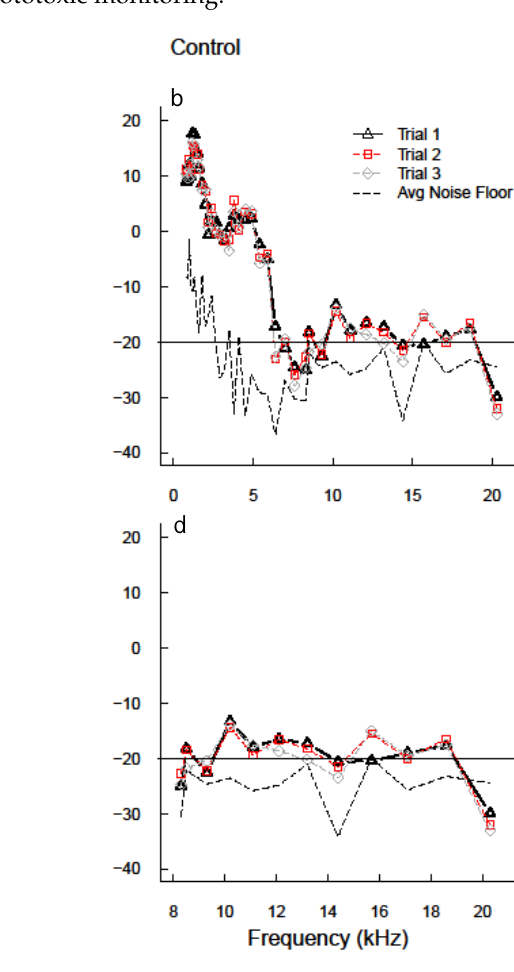
Figure 6. Case illustration of an adult undergoing cisplatin therapy (Exposed; left; a; c; same patient as Figure 5) compared to age-matched control subject (Control; right; b; d) for serial measurement of DPOAEs over 3 trials, averaging 3 weeks apart. DPOAE levels recorded for full bandwidth of f 2 frequencies (0.8 to 20 kHz; 1 / 8 octave step; 1.22; 62 / 52 dB FPL; top; a; b) versus limited bandwidth (8 to 20 kHz; bottom; c; d) using standard stimulus parameters. The solid lines with black triangles represent trial 1 (baseline) prior to exposures and the long-dashed lines with red squares or gray diamonds represent trials 2 and 3 (monitoring visits), respectively, for the exposed individual with trials 1–3 for the control individual matched for testing in chronological time. The short-dashed lines without symbols are the average noise floor for all trials for the respective individual. The line at − 20 dB SPL plotted as a reference for visual